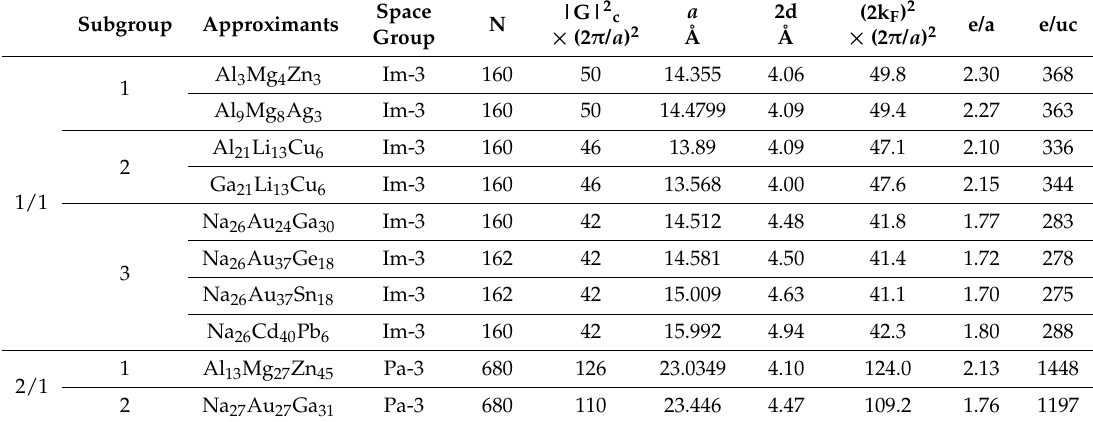
Hume-Rothery electron concentration rule for RT-type 1/1-1/1-1/1 and 2/1-2/1-2/1